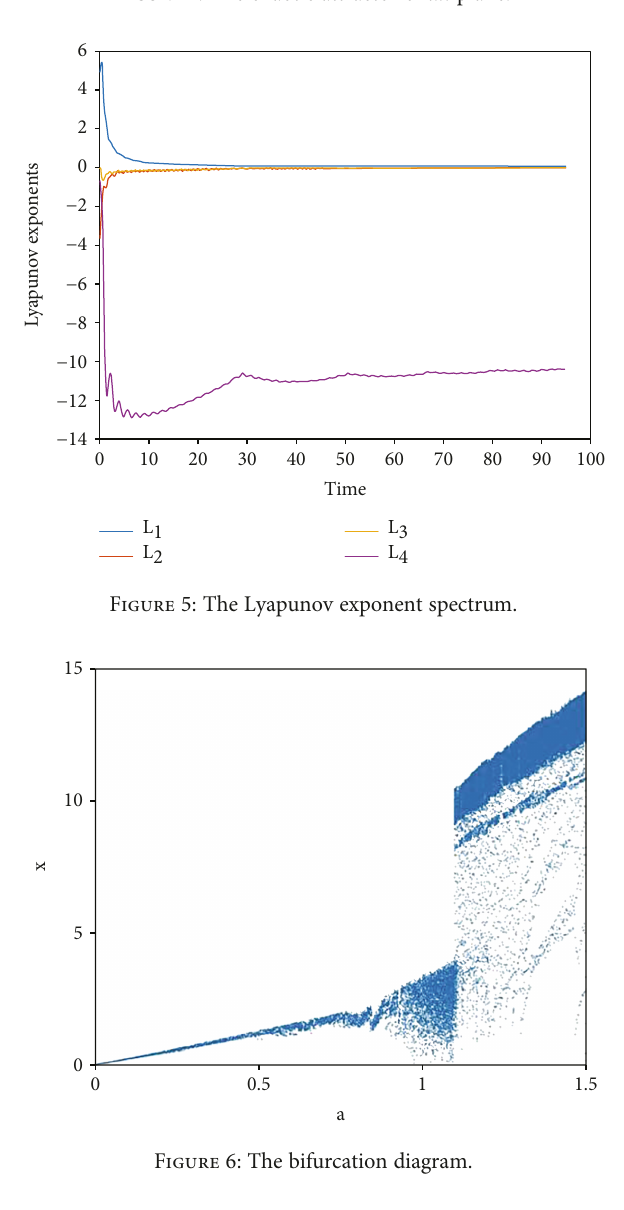
Figure 7: The Poincaré